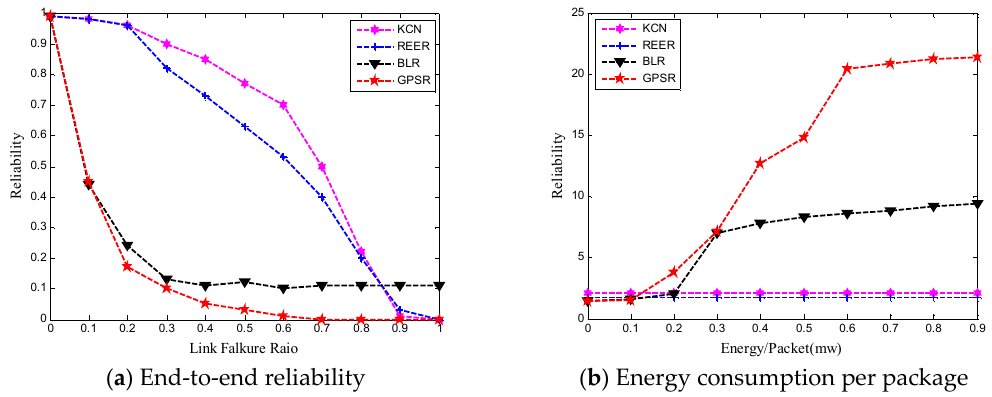
Figure 9. Comparisons of Four Routing Algorithms.